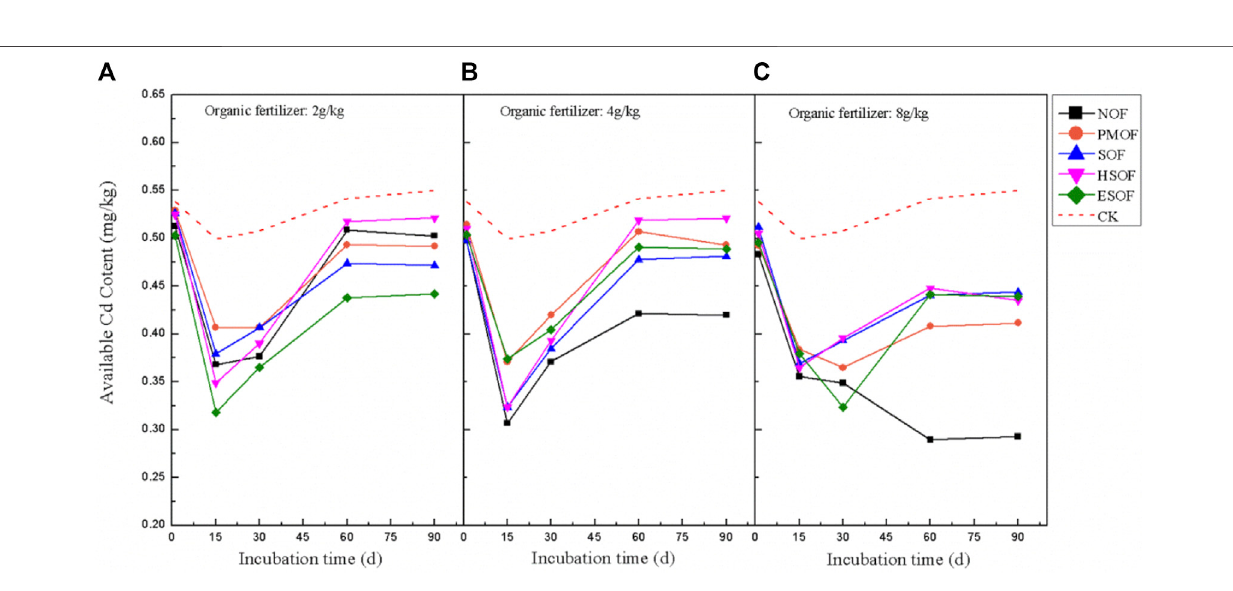
Frontiers in Environmental Science |